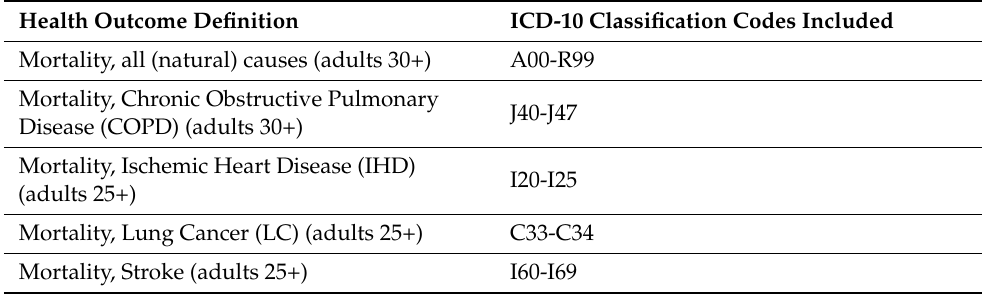
Table 2. Health endpoints (mortality) handled by the AIRQ+ and used in this